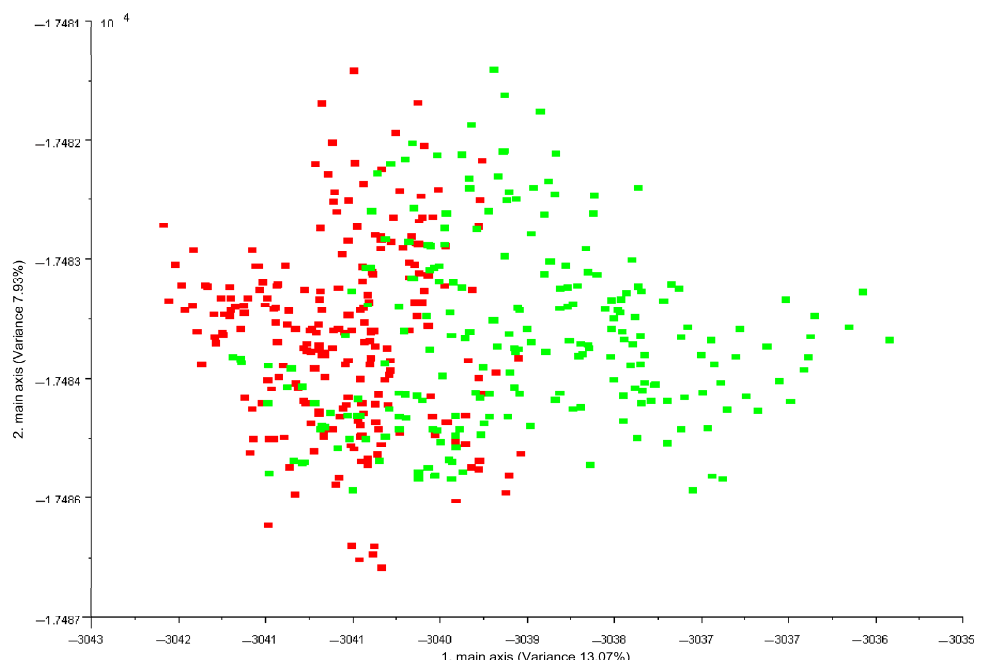
Figure 1. LDA plot of the resulting 10-dimensional patterns (data vectors) obtained from electronic nose analysis of 45 Pasture (green) and 45 Stall (red) individual milk samples. Data processed with Winmuster v.1.6 software (Airsense Analytics GmbH, Schwerin, Germany). Electronic nose provided good discrimination of the two milk labels. P milk exhibited greater variability than S milk. Table 3 shows the confusion matrix with classification of milk samples obtained by LDA analysis.